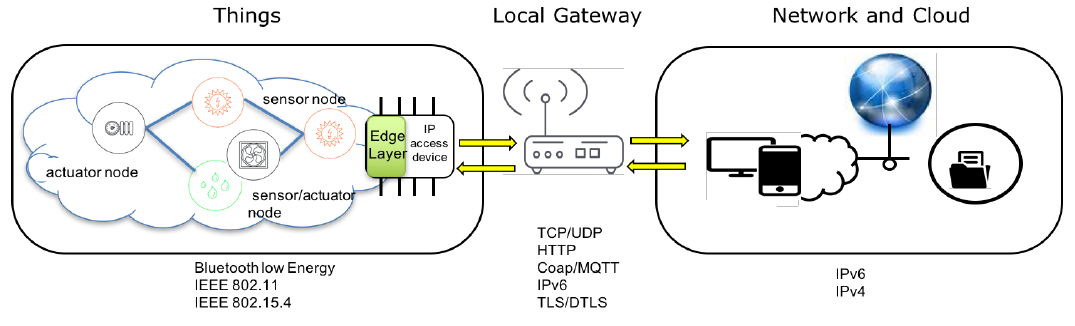
Figure 2. IoT model used: device-to-gateway pattern